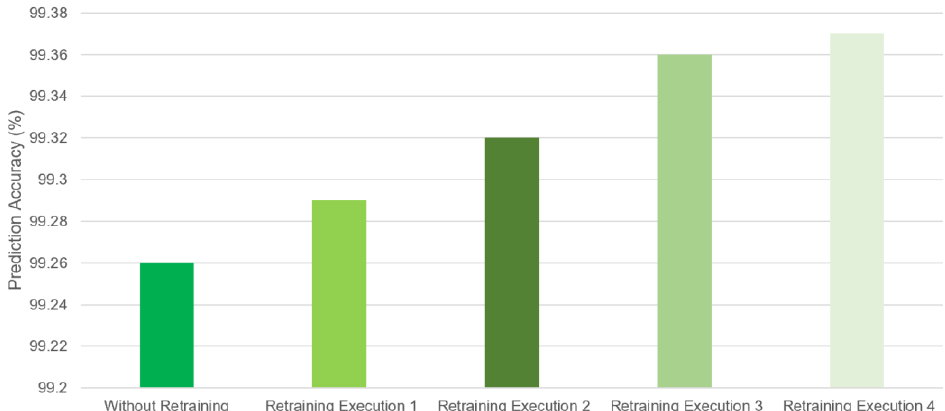
Figure 10. Comparison of the SVSL method, with and without self-training mechanism.